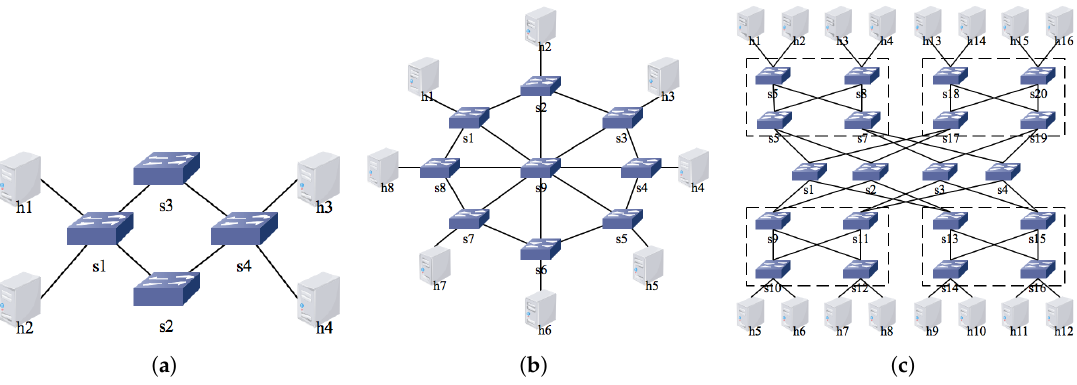
Figure 5. Topologies for experiments. ( a ) The ring topology. ( b ) The mesh topology. ( c ) The fat-tree